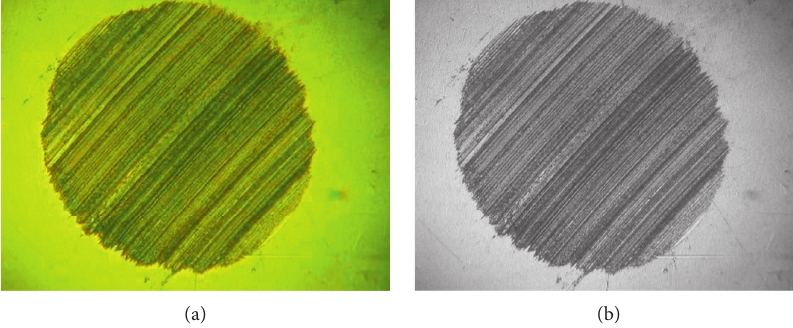
Figure 4: Wear image and its graying. (a) True RGB color wear image F . (b) Grayscale wear image f .